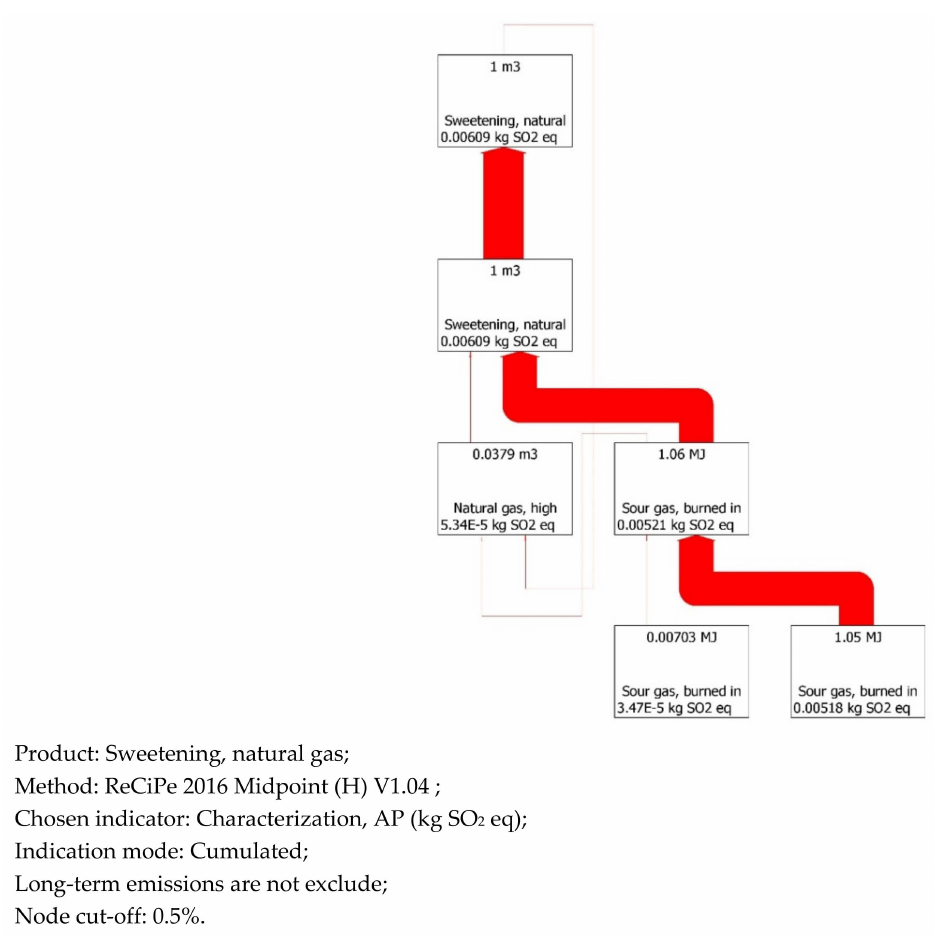
Figure A3. Structural data inventory flows used in the Ecoinvent database in for the AP in (kg SO 2